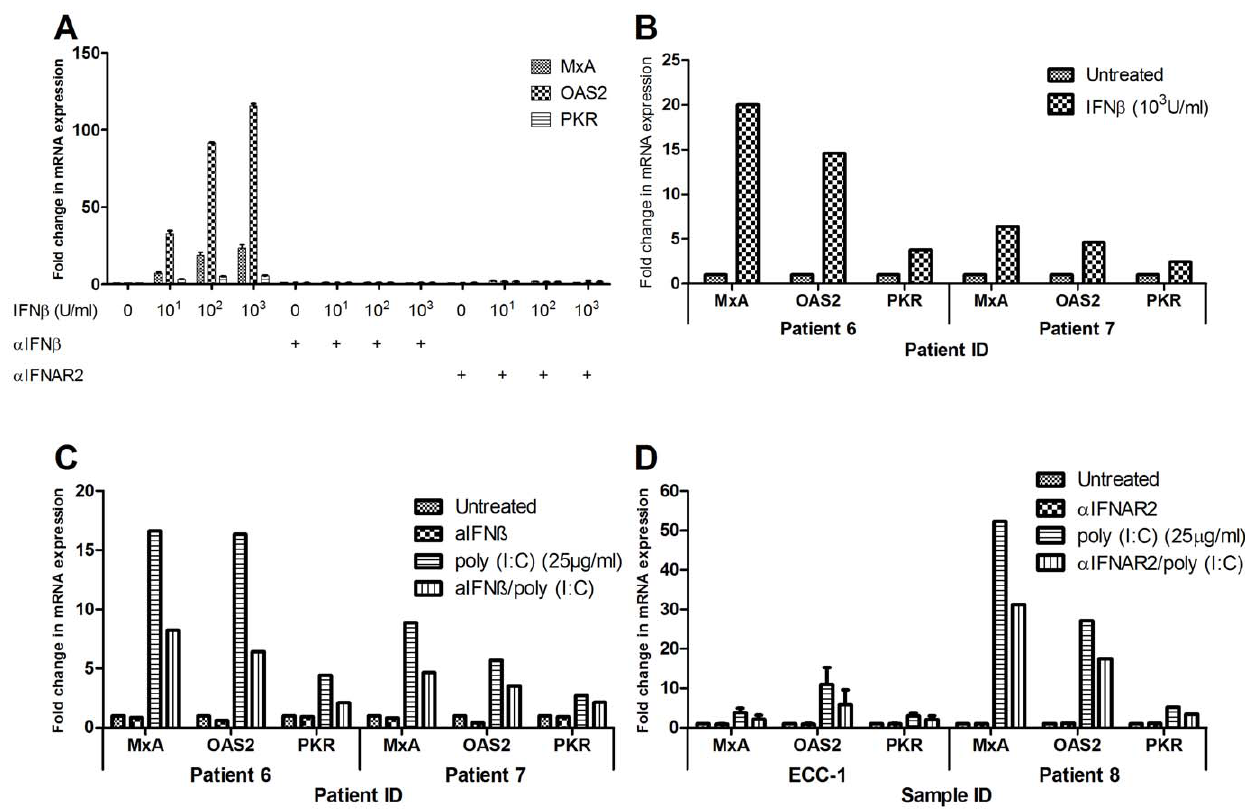
Figure 4. Inhibition of IFN b signaling results in partial abrogation of poly (I:C)-induced ISG upregulation. (a) ECC-1 cells ( n=2 ) were cultured on cell inserts until confluent and subsequently stimulated with multiple doses of recombinant human IFN b (10 1 , 10 2 & 10 3 U/ml) for 24 hours (left panel) in the presence or absence of either neutralizing antibody for IFN b ( a IFN b ) (middle panel) or blocking antibody against interferon receptor 2 ( a IFNAR2) (right panel). For the neutralization experiments a IFN b and IFN b were first mixed together in an eppendorf tube and then added to both compartments for 24 hours. For the receptor blockade experiments cells were pretreated apically and basolaterally with a IFNAR2 or IgG control (not shown) for 1 hour prior to apical stimulation with poly (I:C) for a subsequent 24 hours during which a IFNAR2 was maintained in the cell culture media. (b) Primary human UEC from two individual patients were cultured on cell inserts until confluent and then stimulated with 10 3 U/ml of recombinant IFN b for 24 hours. (c) Concurrently, the UEC were treated with poly (I:C) for 24 hours in the presence or absence of neutralizing antibody for IFN b ( a IFN b ). (d) ECC-1 cells ( n=3 ) or primary human UEC (Patient 8) (representative of 2 separate experiments) were cultured on cell inserts until confluent. Cells were pretreated with a IFNAR2 or IgG control (not shown) for 1 hour prior to apical stimulation with poly (I:C) for a subsequent 24 hours during which a IFNAR2 was maintained in the cell culture media. Total cellular mRNA was recovered and analyzed for gene expression. mRNA is expressed as a fold change over untreated samples (assigned a value of